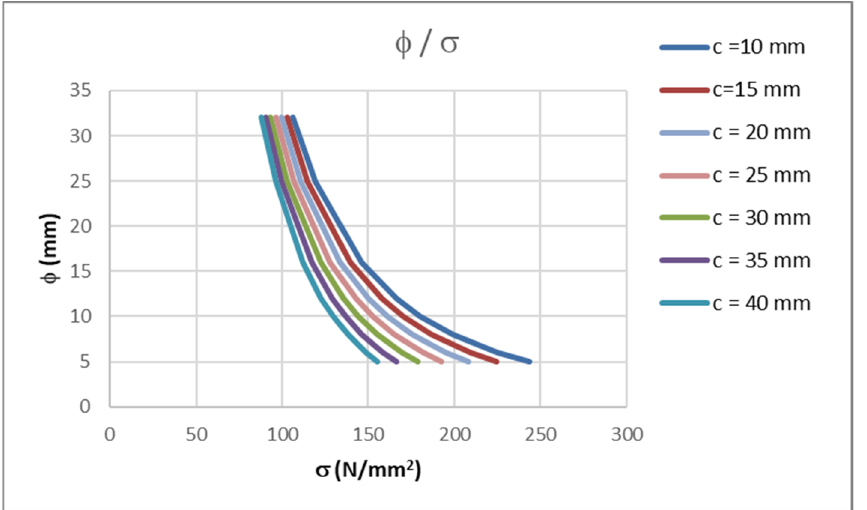
Figure 4. Stresses in FRP bars for maximum allowable bar diameter and different concrete covers.